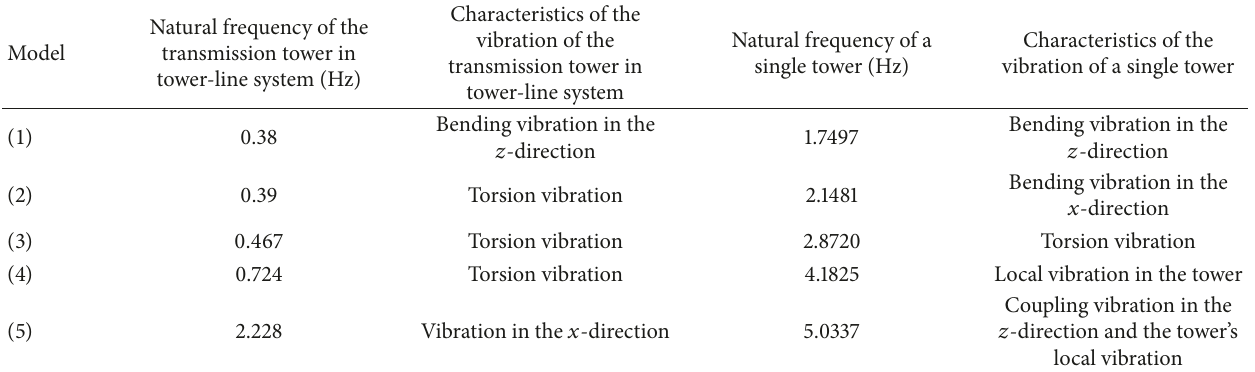
Table 4: Comparison of the natural frequencies of the transmission tower-line system and a single transmission